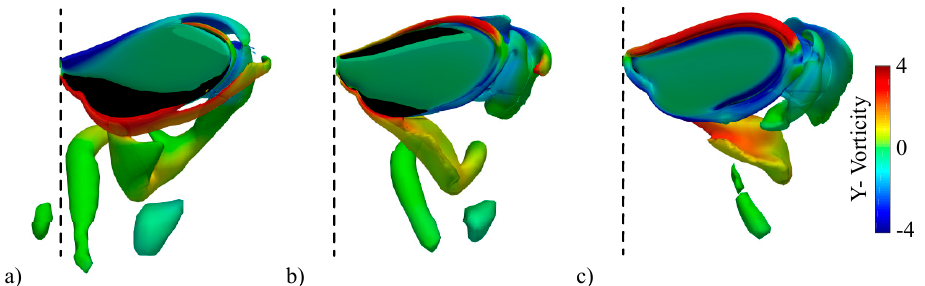
Figure 11. NSe iso-surfaces of Q -criterion at Q = 0.75 and colored with Y- vorticity for the following motions: ( a ) x pa = 0, A = 30°, and Δ τ r = 0.3 at t / T = 0.0, ( b ) x pa = 0.5, A = 30°, and Δ τ r = 0.3 at t / T = 0.0, and ( c ) x pa = 1.0, A = 30°, and Δ τ r = 0.3 at t / T = 0.0.